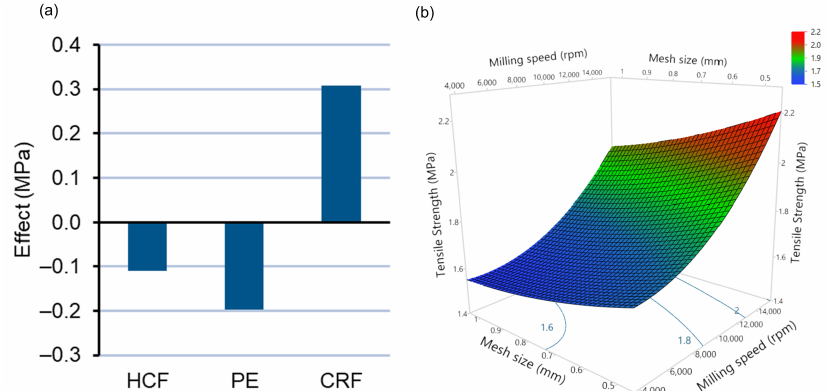
Figure 7. ( a ) Plot depicting the effect of type of feedstock on tensile strength (MPa). ( b ) Response surface plot depicting the effects of milling speed and mesh size on tensile strength